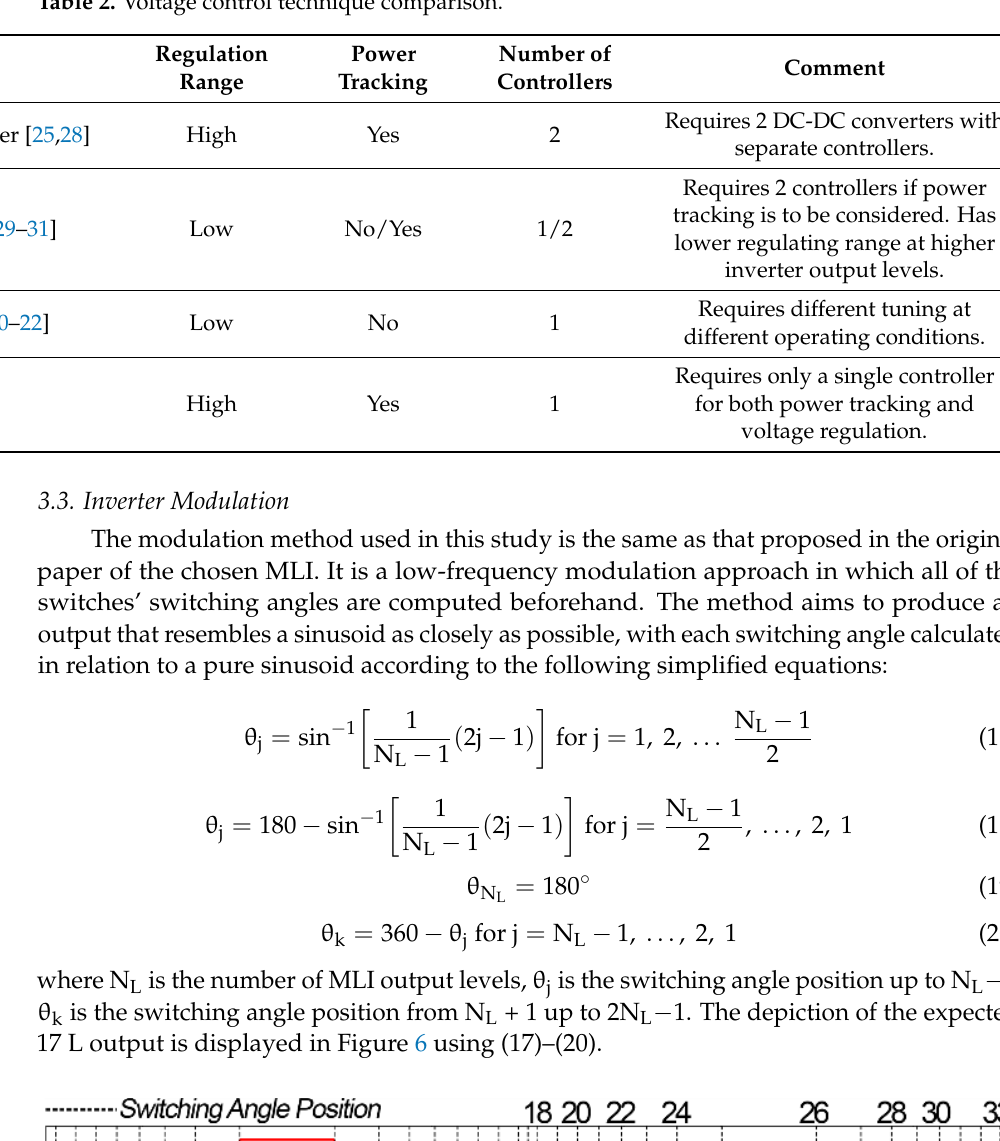
Table 2. Voltage control technique comparison.